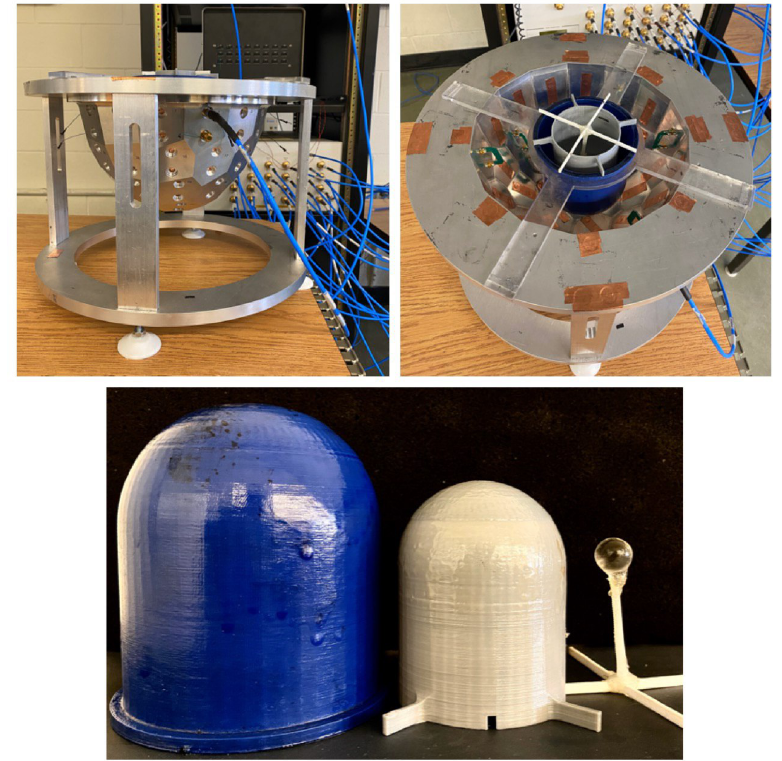
Figure 11. The experimental system including the three region breast phantom (Diameter of fat, fibroglanduar and tumor regions are 10 , 8 and 2 CM